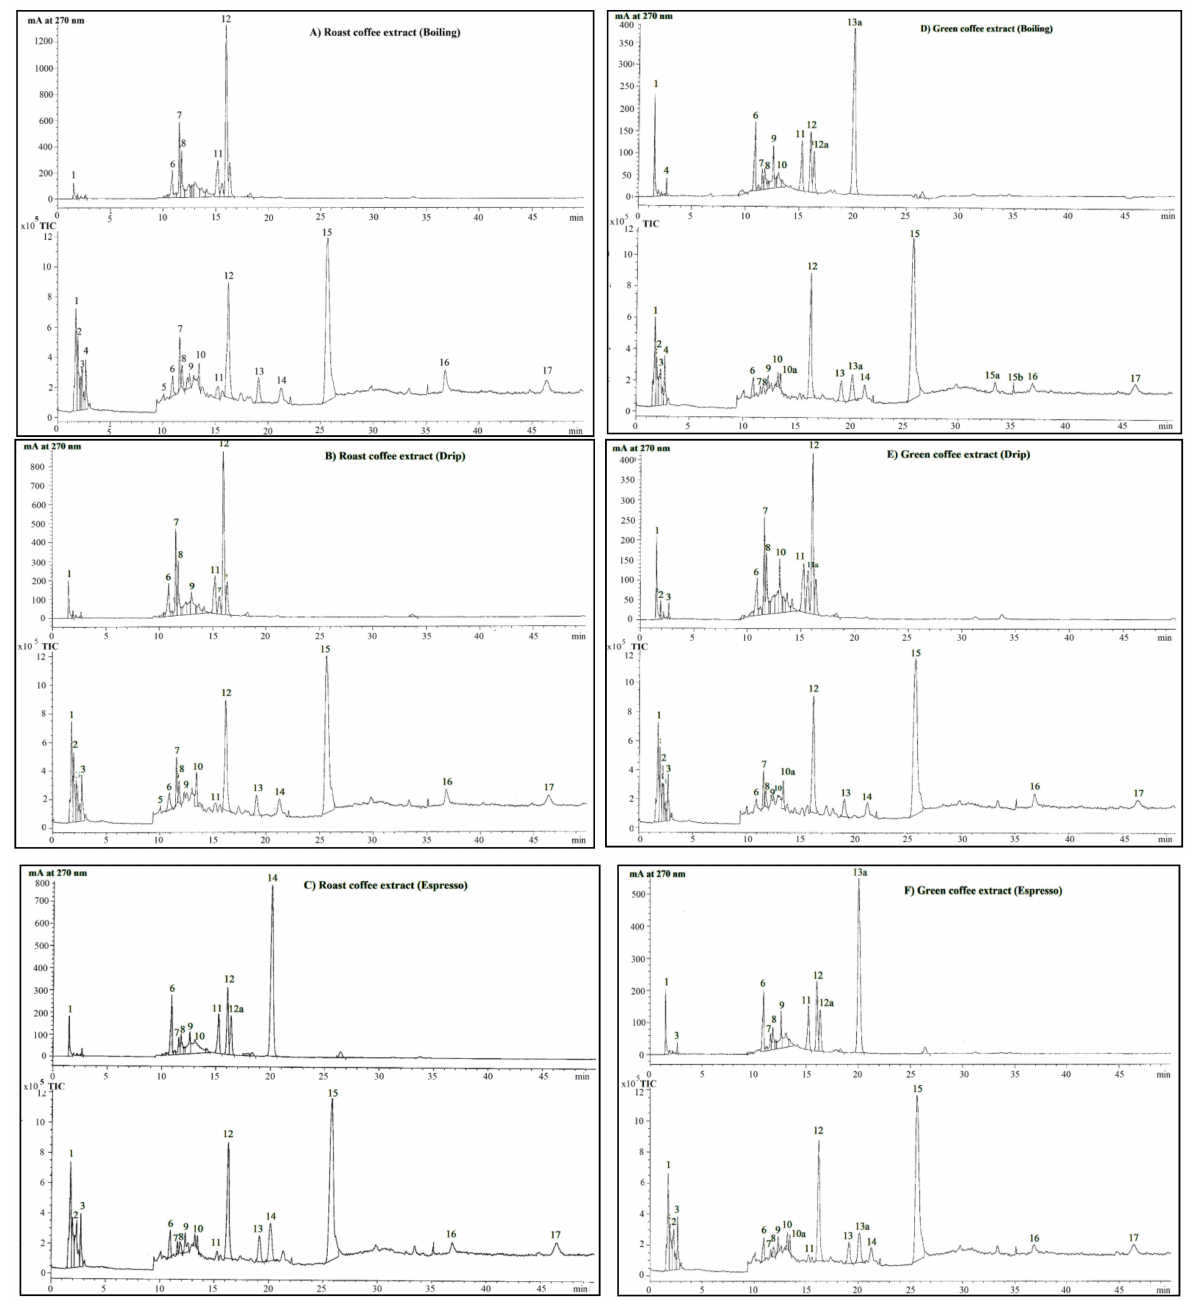
Figure 1. Chromatograms of the phenolic compounds in roasted and green coffee extracts. Roasted and green coffee were extracted with hot water using the boiling, drip and espresso methods. Phenolic compounds in the coffee extracts were identified using HPLC-ESI-MS, as has been described in Section